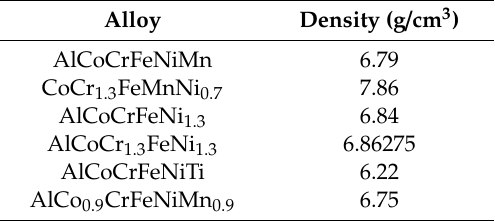
Table A4. Comparison of alloys and density values for short-listed HEAs.